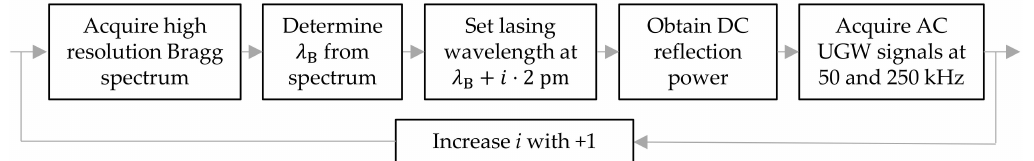
Figure 6. Block diagram showing the steps of the spectral reconstruction of the Bragg peak during UGW passage.